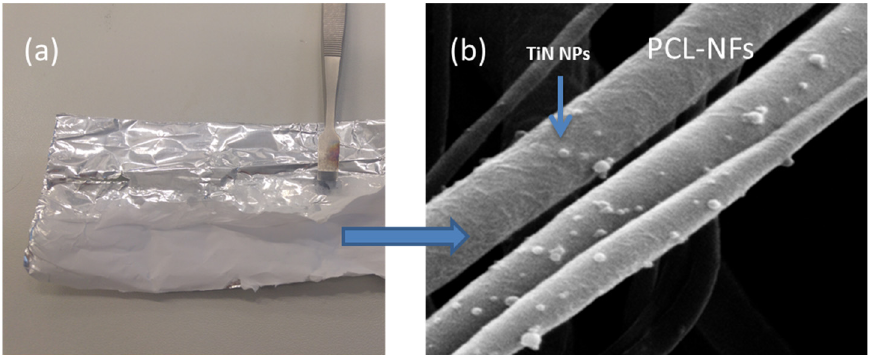
Figure 4. Illustrative image of polycaprolactone nanofibers decorated with TiNNPs elaborated by the PLAL process ( a ) with its corresponding SEM (Scanning electron microscopy) micrograph ( b ). ( b ) is adapted from Reference [95].